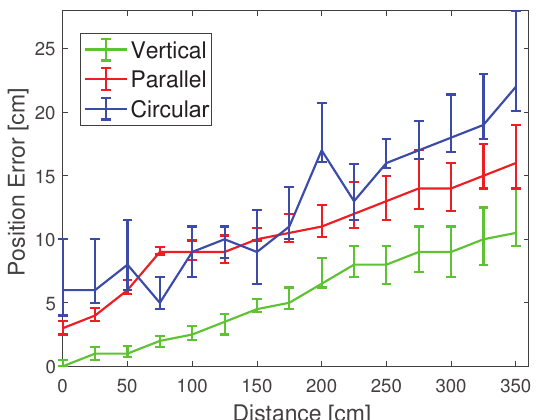
Figure 9. Impact of different color polarizer placements.